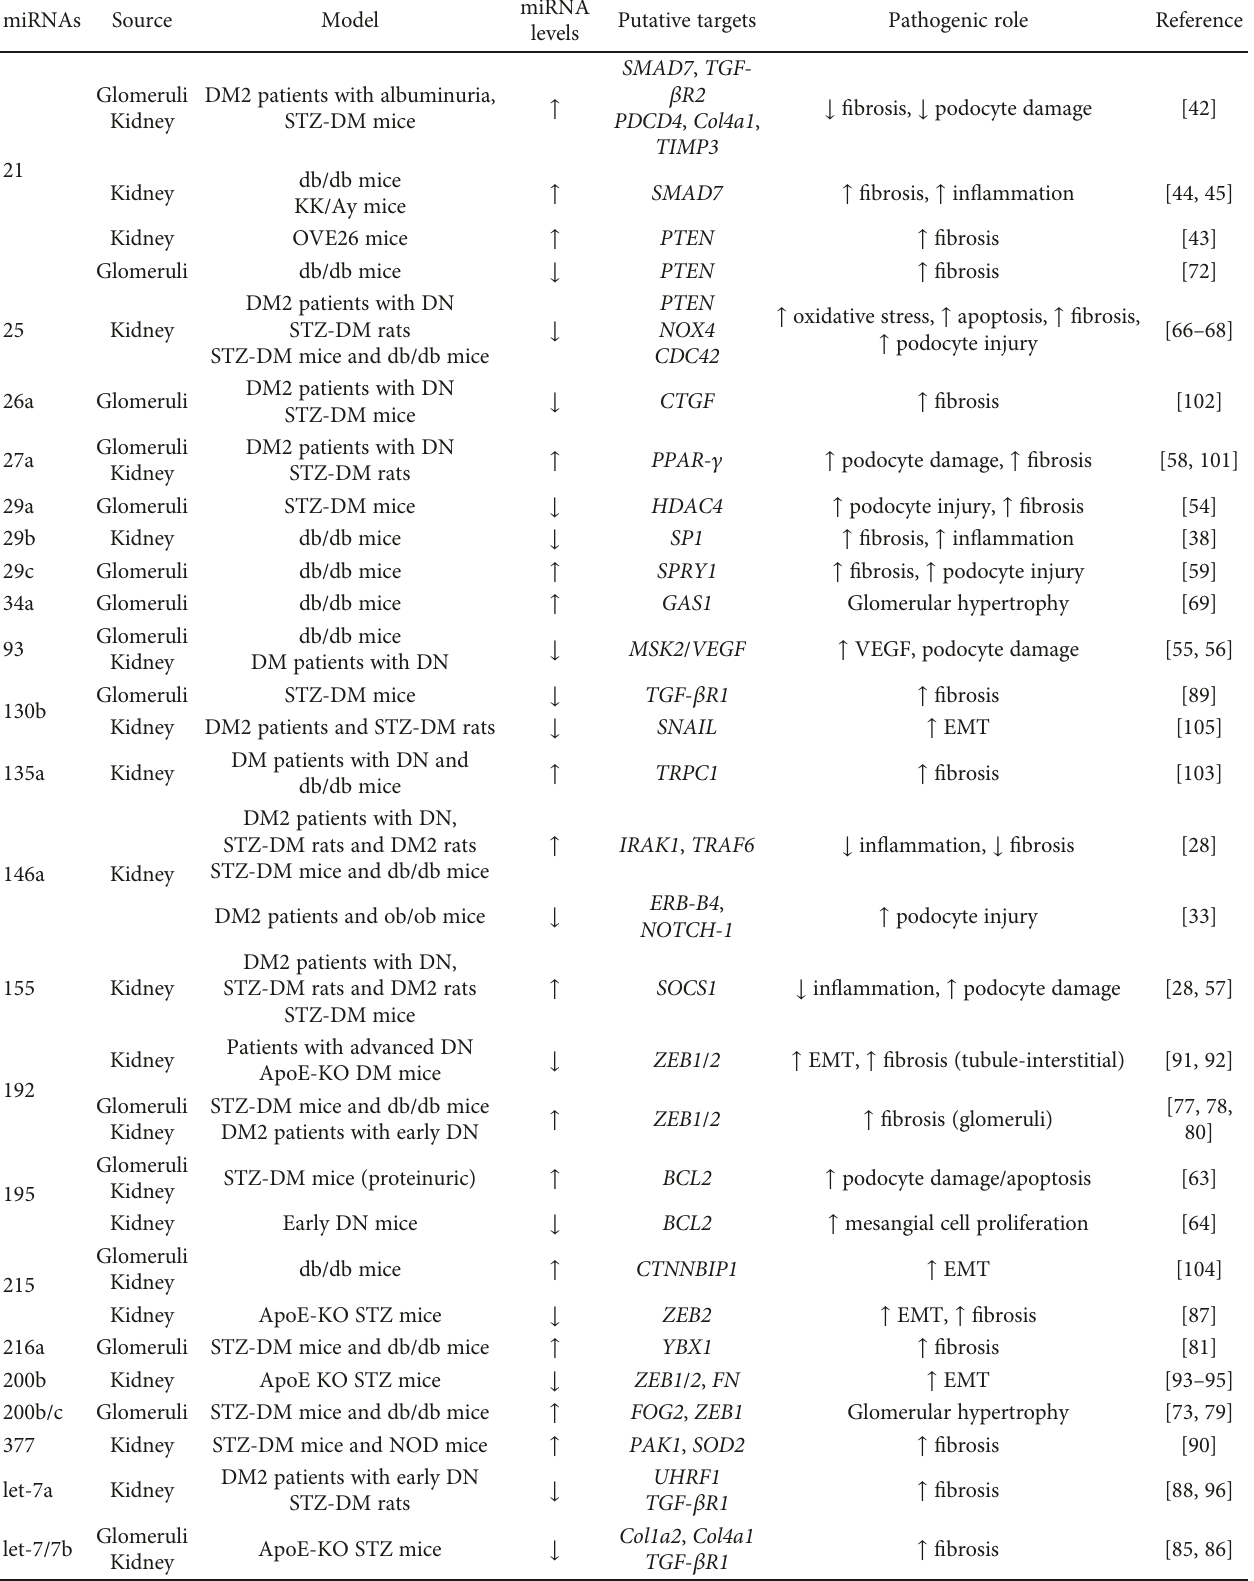
Table 4: MicroRNA involved in diabetic